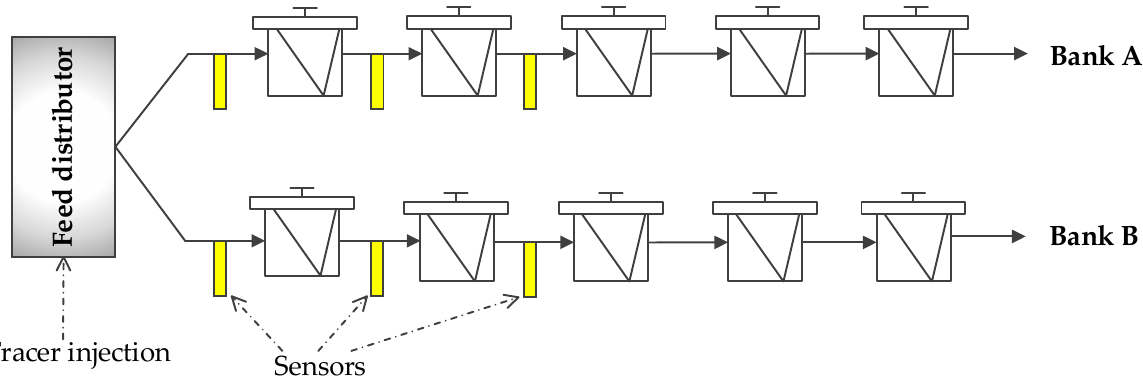
Figure 3. Tracer injection and sensor location in rougher banks A and B .